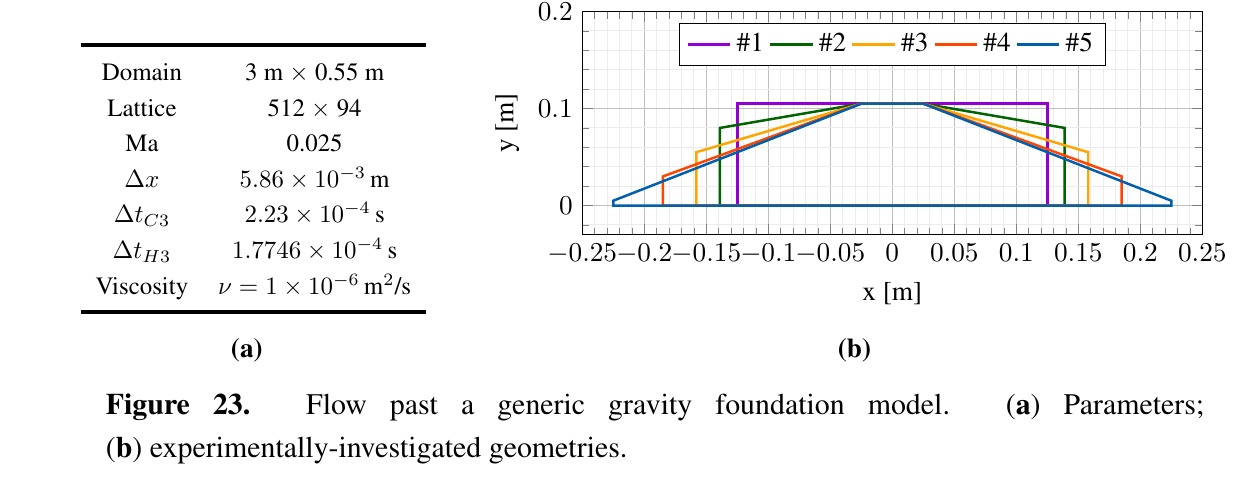
Figure 23. Flow past a generic gravity foundation model. ( a ) Parameters; ( b ) experimentally-investigated geometries.